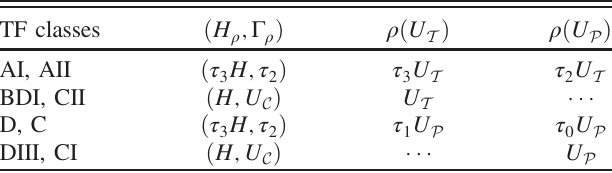
TABLE XVII. The mapped Hamiltonian (B6) and the repre- sentation of the antiunitary (anti)symmetries T and P under application of the dimension-raising isomorphism ρ for the real tenfold-way classes.